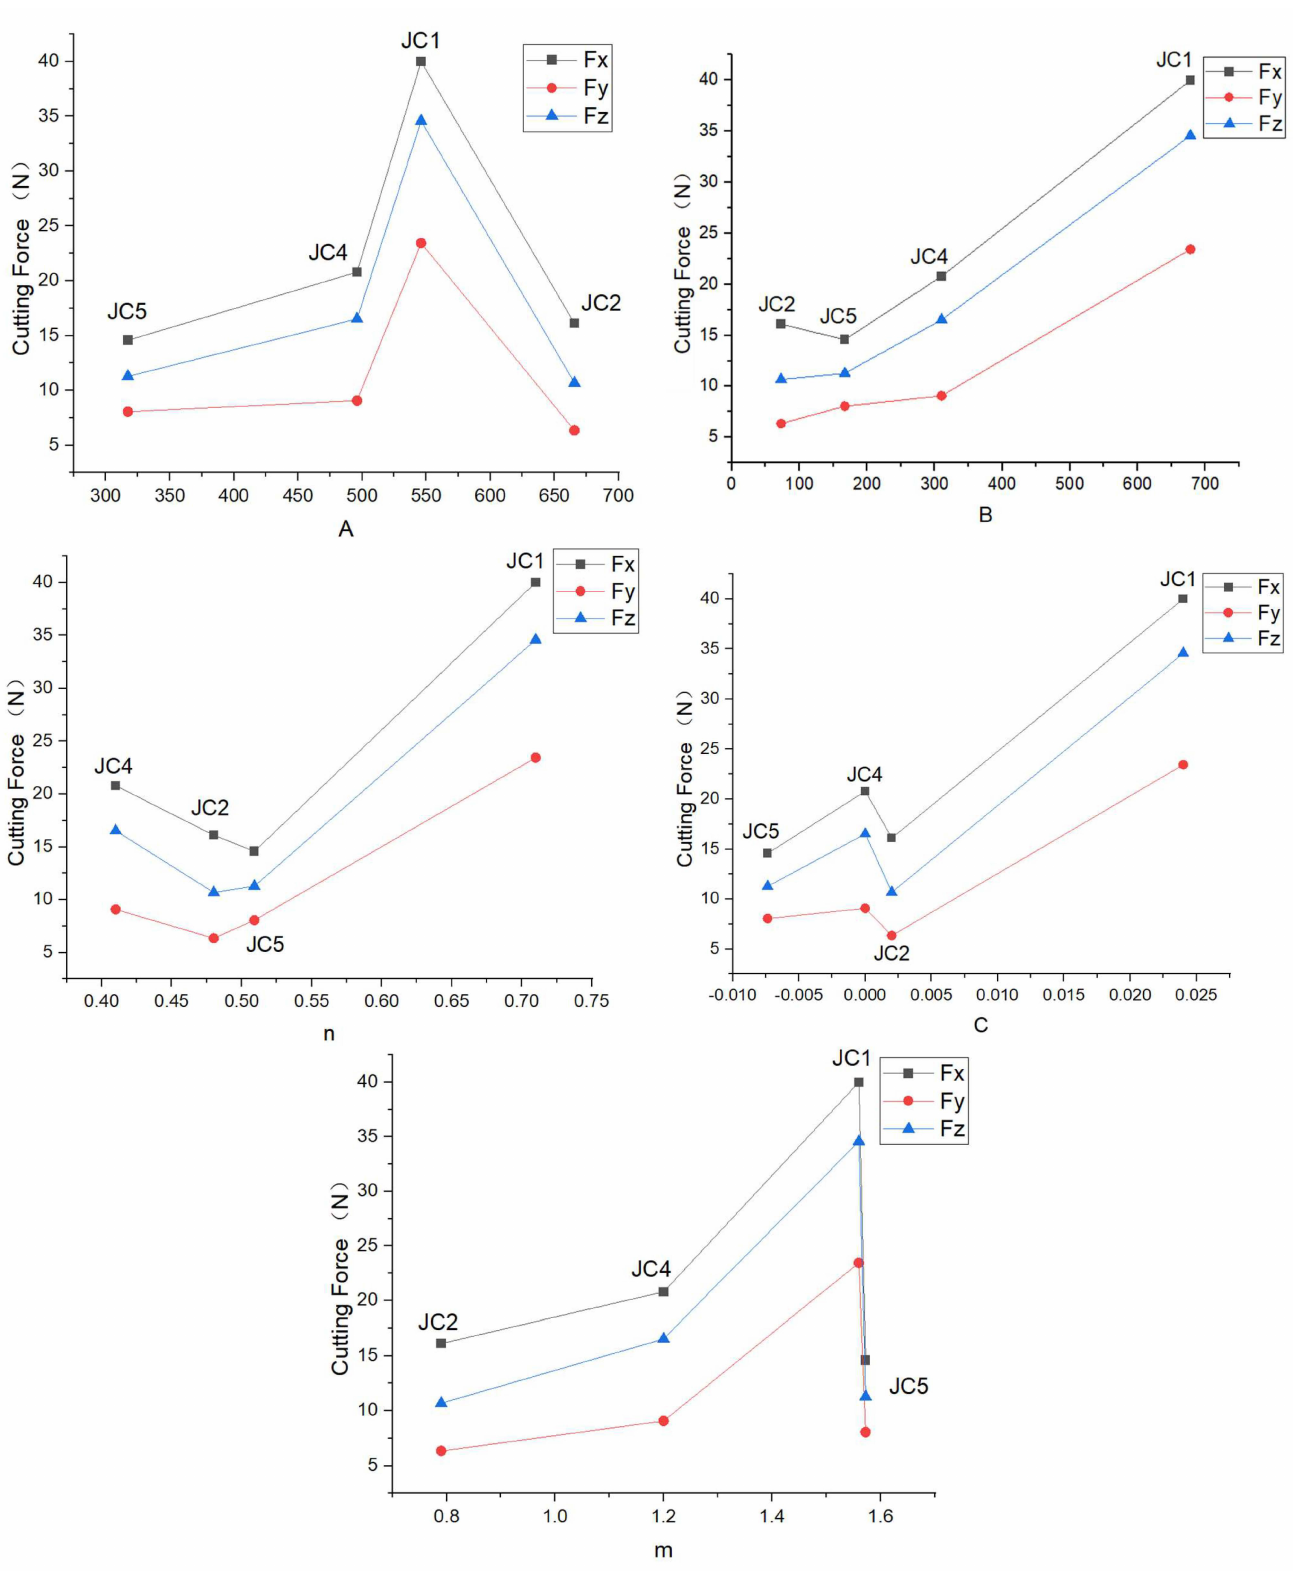
Figure 7. The influence of various parameters of Johnson − Cook constitutive model on cutting force (the cutting force values are smaller for high-speed cutting conditions than for conventional